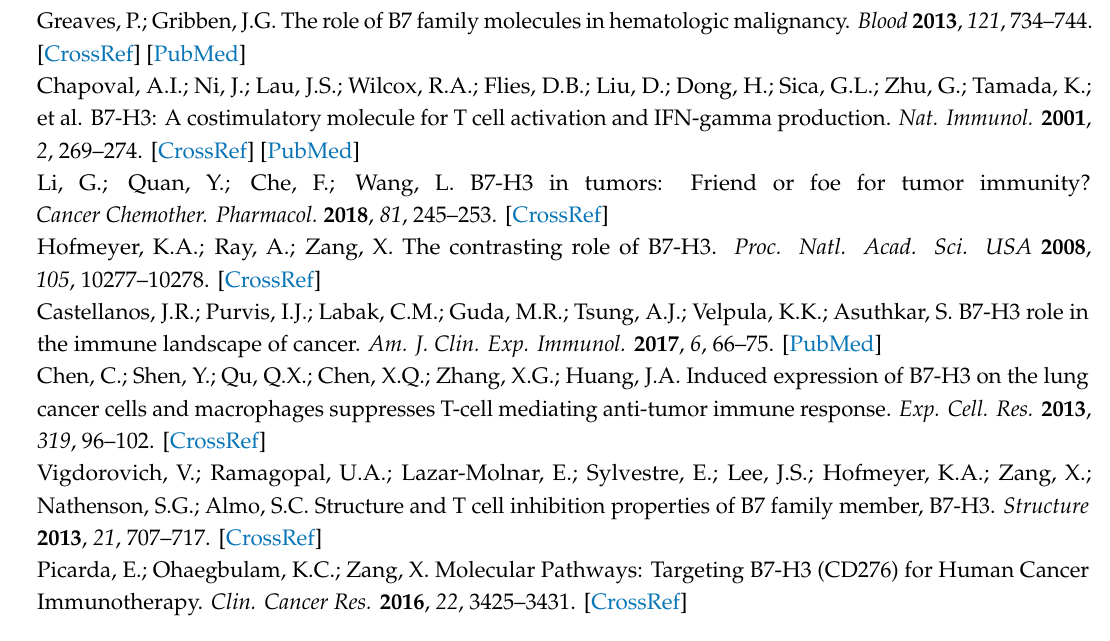
Figure S1: B7-H3 expression on cancer cell lines. Figure S2: (A) background induction of NK cell activation by TriKE; (B-D) induction of NK cell activation by individual components of the TriKE; (E-F) Comparison of TriKE mediated activation against di ff erent cell lines. Figure S3: TriKE mediated in vivo toxicity and